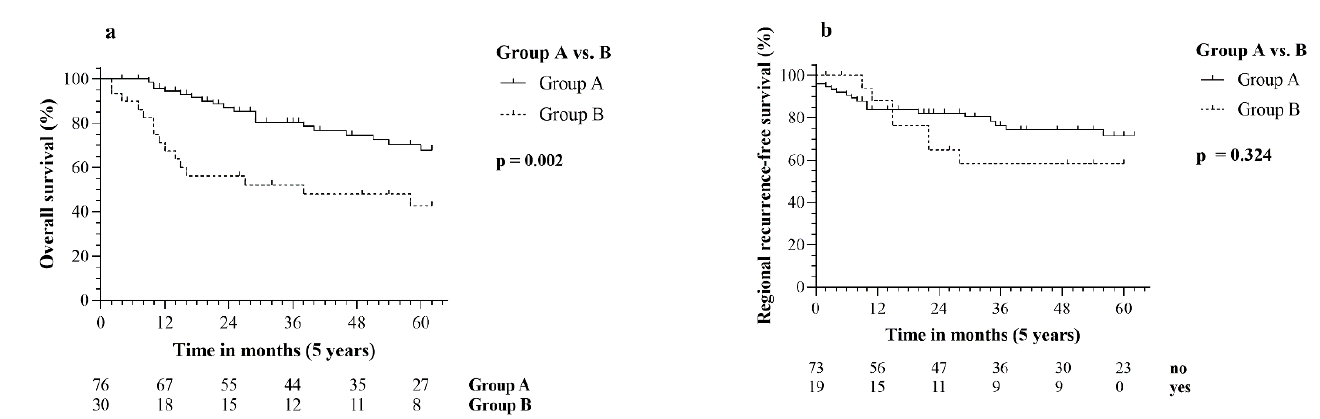
Figure 1. Kaplan–Meier curves: ( a ) 5-year overall survival and comparison of group A (CUP) vs. group B (tCUP); ( b ) 5-year regional recurrence-free survival and comparison of group A (CUP) vs. group B (tCUP).